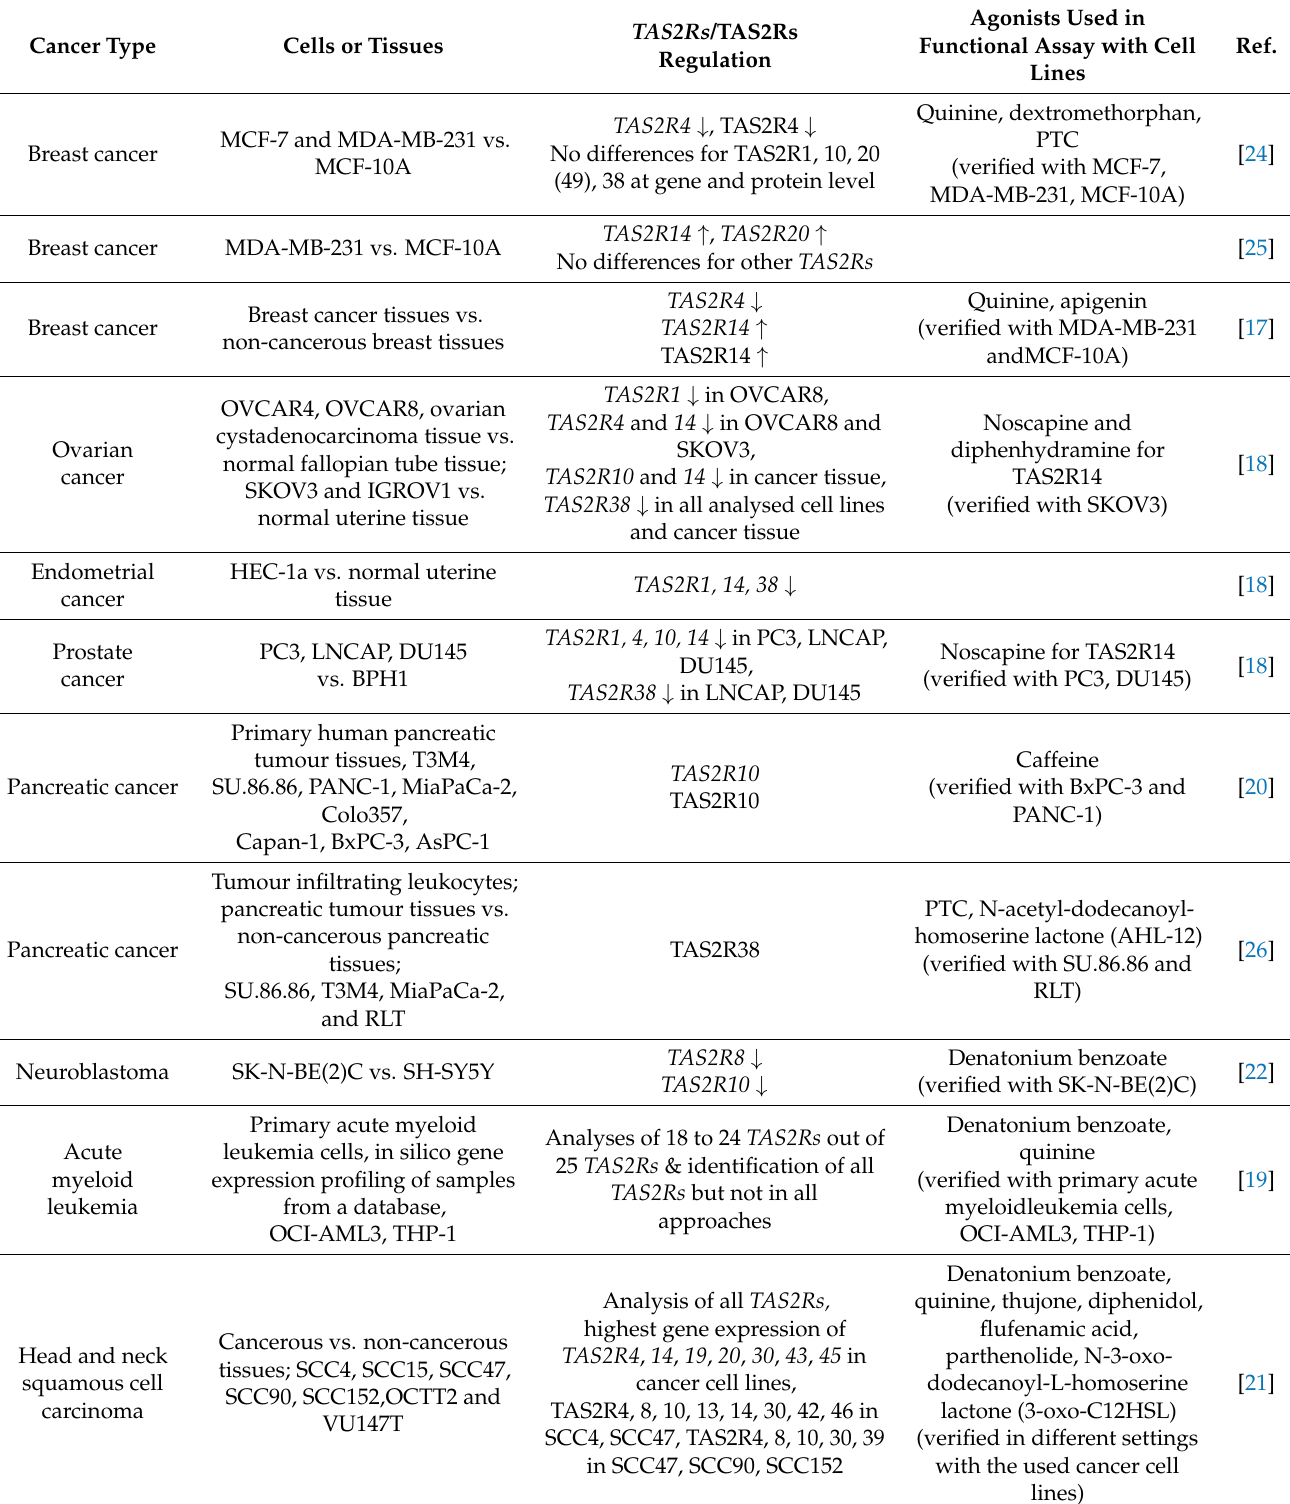
Table 1. Overview of expression level of bitter taste receptors at gene and protein level in cancerous cell lines and tissues compared to non-cancerous cell lines and tissues as well as analysed